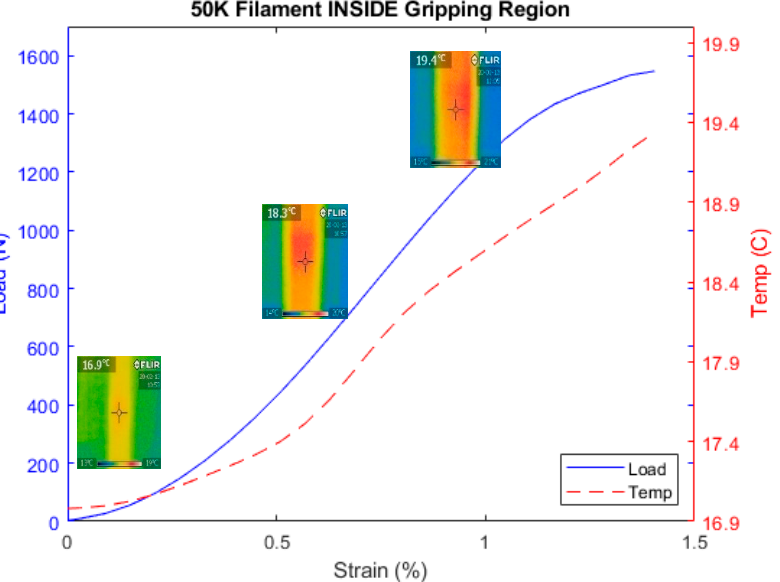
Figure 17. Load and temperature measurements of the 50 K carbon fiber under full tensile test.